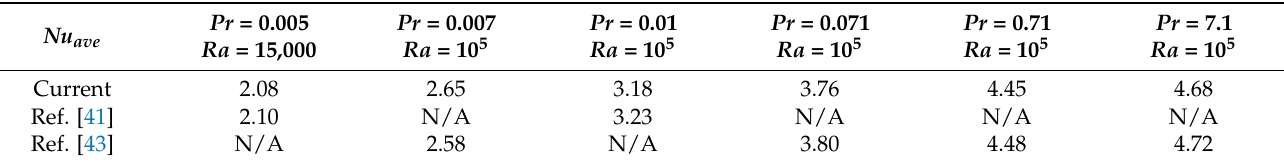
Table 3. Comparison of Nu ave for different Pr